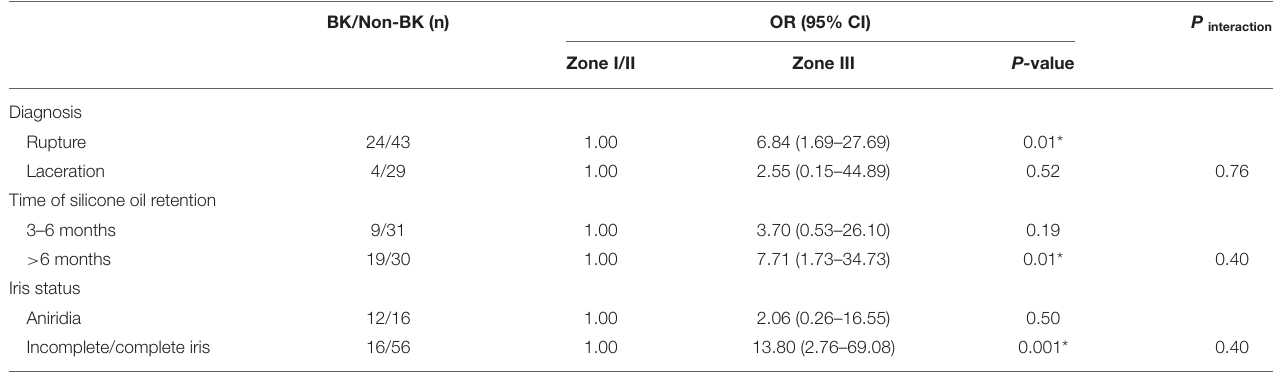
TABLE 4 | Association between the zone of injury and band keratopathy stratified by diagnosis, time of silicone oil retention, and iris